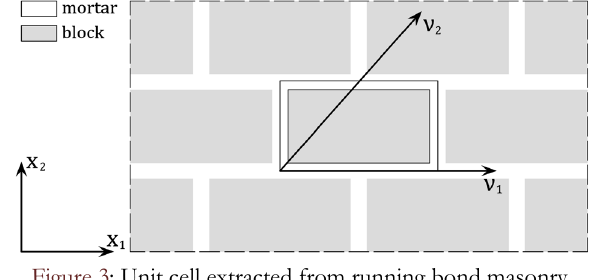
Figure 3: Unit cell extracted from running bond